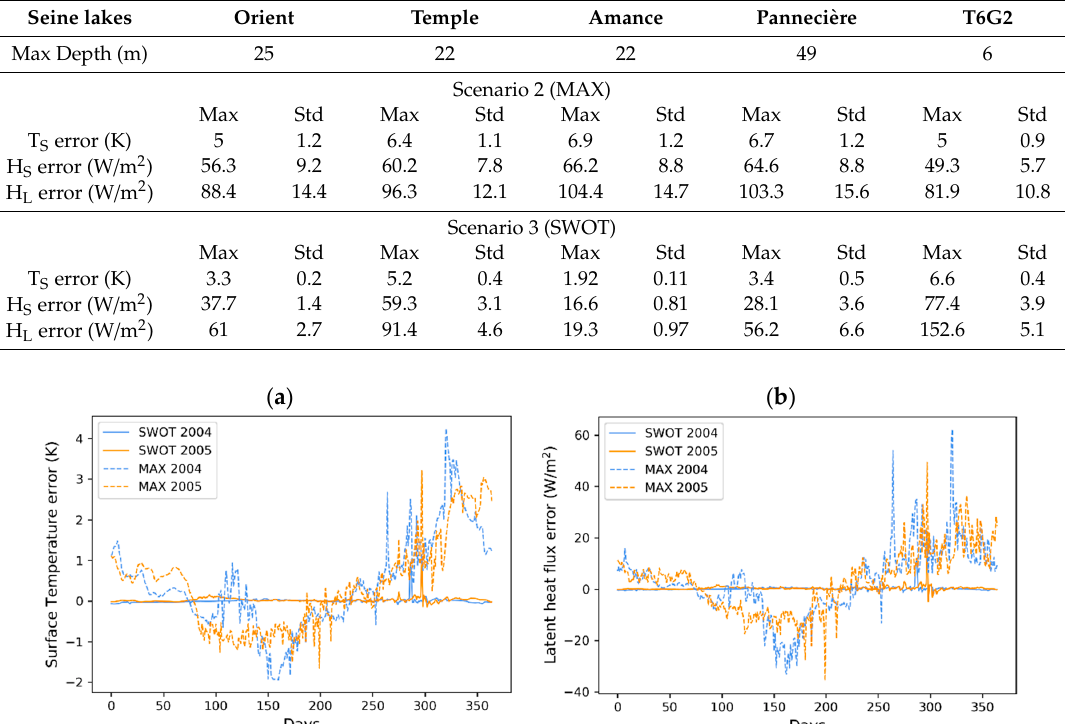
Figure 8. Temporal evolution of the surface temperature (in K) ( a ) and latent heat flux (in W/m 2 ) ( b ) errors calculated for the Orient reservoir and for the years 2004 and 2005. The two depth scenarios SWOT (depth forced to SWOT-like measurements) and MAX (constant depth equal to reservoir maximal capacity) are compared to the REF (actual depth) one.